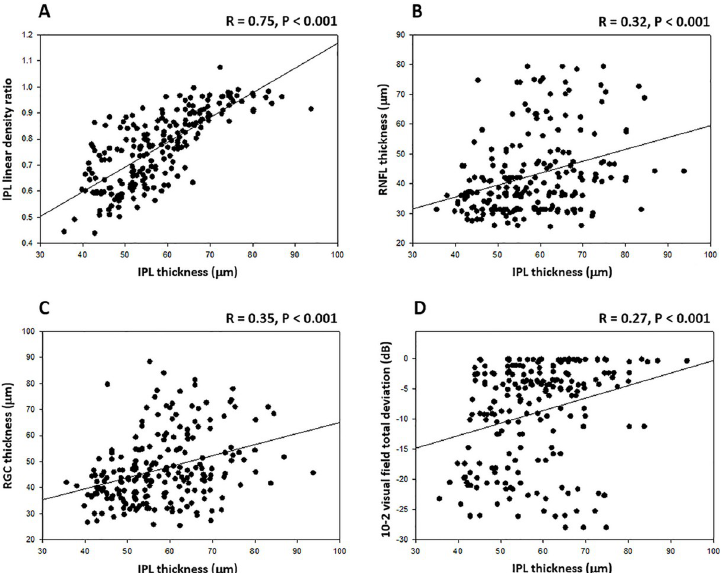
Fig 2. Baseline association of imaging parameters and visual field scores in patients with glaucoma. Presented include linear regression plots that show a significant relationship between the baseline values of IPL thickness and IPL linear density ( A ), IPL thickness and RNFL thickness ( B ), IPL thickness and RGCL thickness ( C ), and IPL thickness and 10–2 visual field total deviation ( D